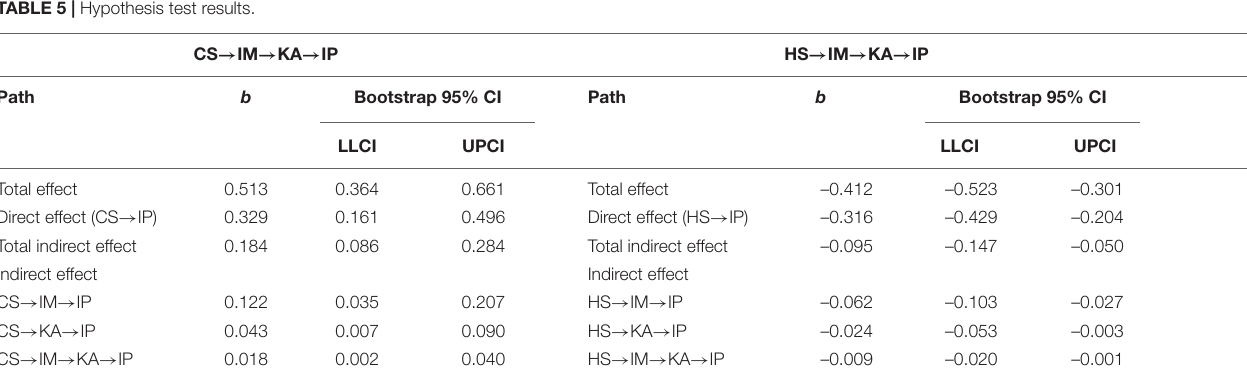
TABLE 5 | Hypothesis test